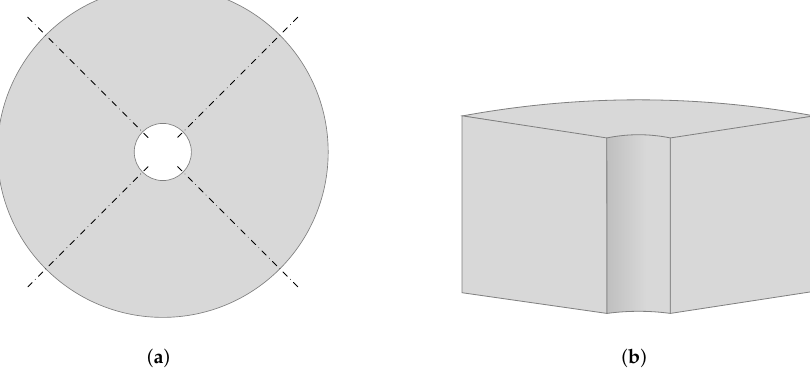
Figure 5. Cutting procedure: ( a ) cutting zones; and ( b ) sample used for XRD